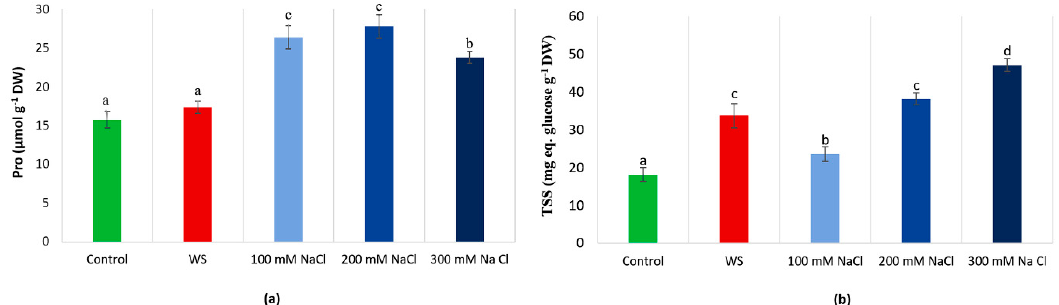
Figure 5. Needle contents of ( a ) proline (Pro) and ( b ) total soluble sugars (TSS), in one-year-old A. alba seedlings after 30 days of growth in the presence of the indicated NaCl concentrations or subjected to water deficit stress (WS). Bars represent means ± SE ( n = 7). Different letters above the bars indicate significant differences between treatments, according to Tukey’s test ( α = 0.05).